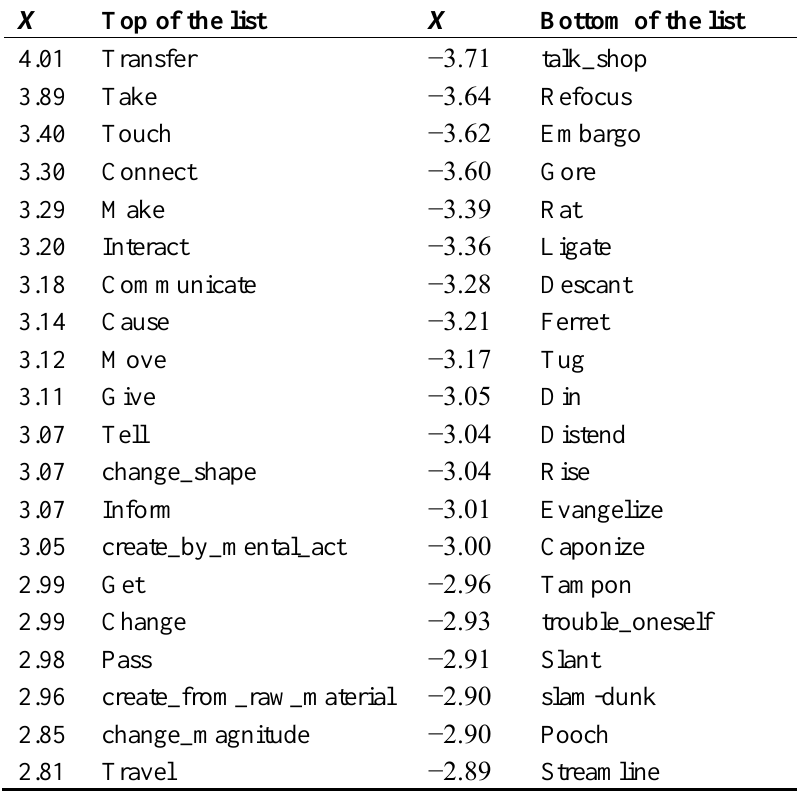
6. ( A ) Verb troponymy map constructed from word senses based